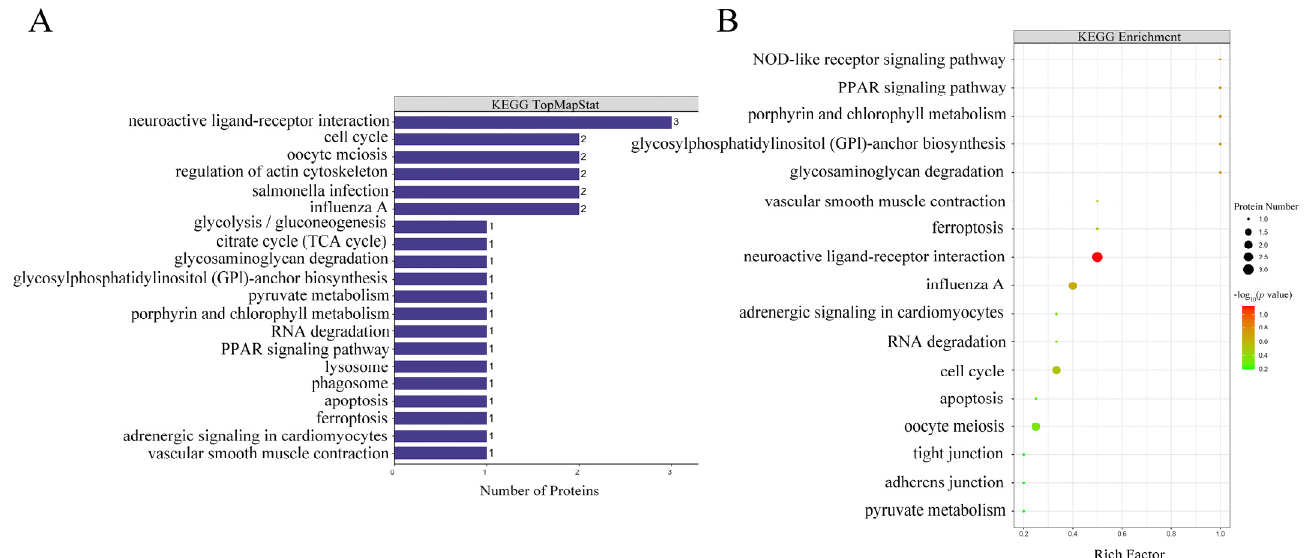
Figure 3. KEGG annotations and pathway enrichment analysis results. Panel ( A ) represents KEGG pathway annotate results of differentially abundant proteins. The vertical axis represents KEGG pathways and the horizontal axis represents the number of differentially abundant proteins involved in each pathway. Panel ( B ) represents KEGG pathway enrichment results of differentially abundant proteins. The vertical axis represents different KEGG pathways and the horizontal axis represents the enrichment factor ( ≤ 1; numbers of differentially abundant proteins associated with a KEGG pathway/numbers of characterized proteins corresponding to the pathway). The colors of the bubble indicate the significance of the enriched KEGG pathway, and the color gradient from green to red represents the increasing significant difference.